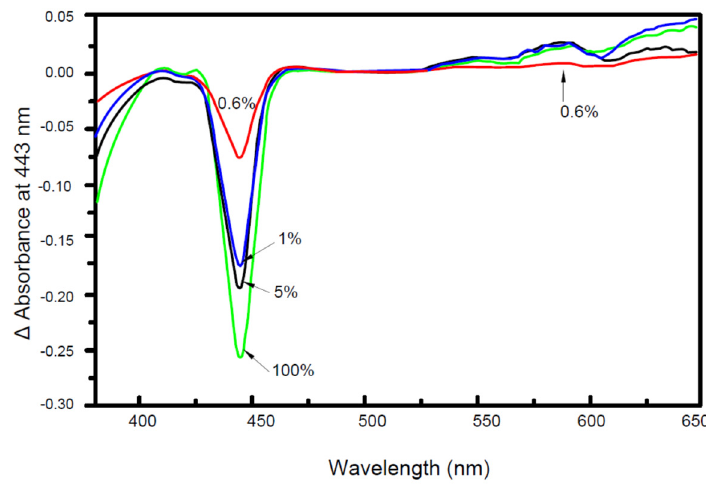
Figure 2. Spectral changes of the reduced form of isolated cholate-CytOx from bovine heart by ADP or ATP. The UV-VIS absorption difference spectra were measured with 100% ATP (5 mM) in the reference cuvette. While the sample cuvette contained the indicated percentage of ADP i.e., 0.6 to 100% (ADP + ATP = 5 mM = 100%). Before measurements, samples containing 3 μ M of isolated CytOx in 50 mM potassium phosphate (pH 7.4), 1 mM EDTA, 1% Tween-20 and the indicated nucleotides were incubated for 24 h at 0 °C. Just before measurement, 2 mM sodium dithionite was added for reduction. The optical spectrum of heme a is red-shifted as known in case of aa 3 -type cytochrome c oxidases. Early spectroscopic studies in Paracoccus denitrificans indicated that this may be due to hydrogen-bonding of the formyl group of heme a to an amino acid in the close vicinity. Even here, the optical spectral shift of native heme a is suggested because of a hydrogen-bonding interaction between the formyl group and arginine-54 in subunit I of cytochrome aa 3 , and that a smaller part is due to an electrostatic interaction between the D ring propionate of heme a and arginine-474 [34].